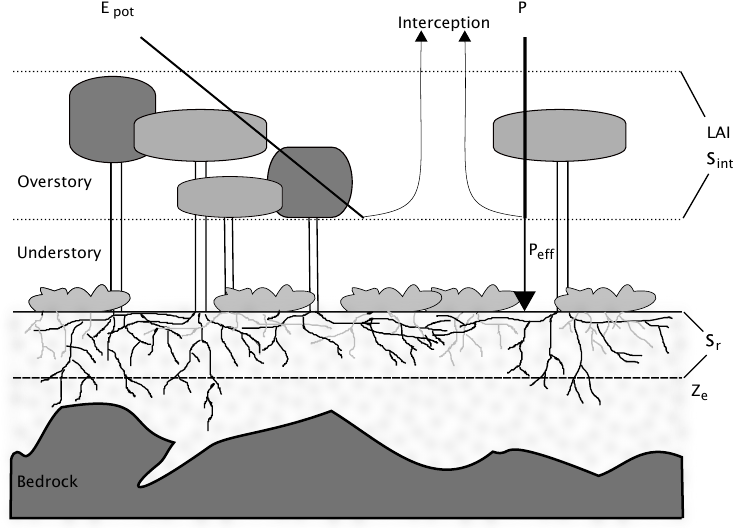
Figure 1. Schematic representation of a forest stand, together with the simplifications used in this study. The stand is heterogeneous in terms of overstory and understory density, as well as soil depth. In the model, both aboveground and belowground properties are integrated to stand- level variables. The crowns of the overstory trees form a canopy described by the variables leaf area index (LAI) and interception storage capacity ( S int ). LAI determines the partitioning of available energy E pot between potential transpiration of the overstory and understory. Incoming precipitation is divided between effective precipitation reaching the ground P eff , and interception. No distinction is made between understory transpiration, understory interception evaporation and soil evaporation. Below ground, rooting depth is expressed as a stand-scale average ( Z e ) . Rooting zone water storage capacity S r is the product of Z e and soil water holding capacity, assumed to be constant over the whole stand, despite its high horizontal and vertical heterogeneity in